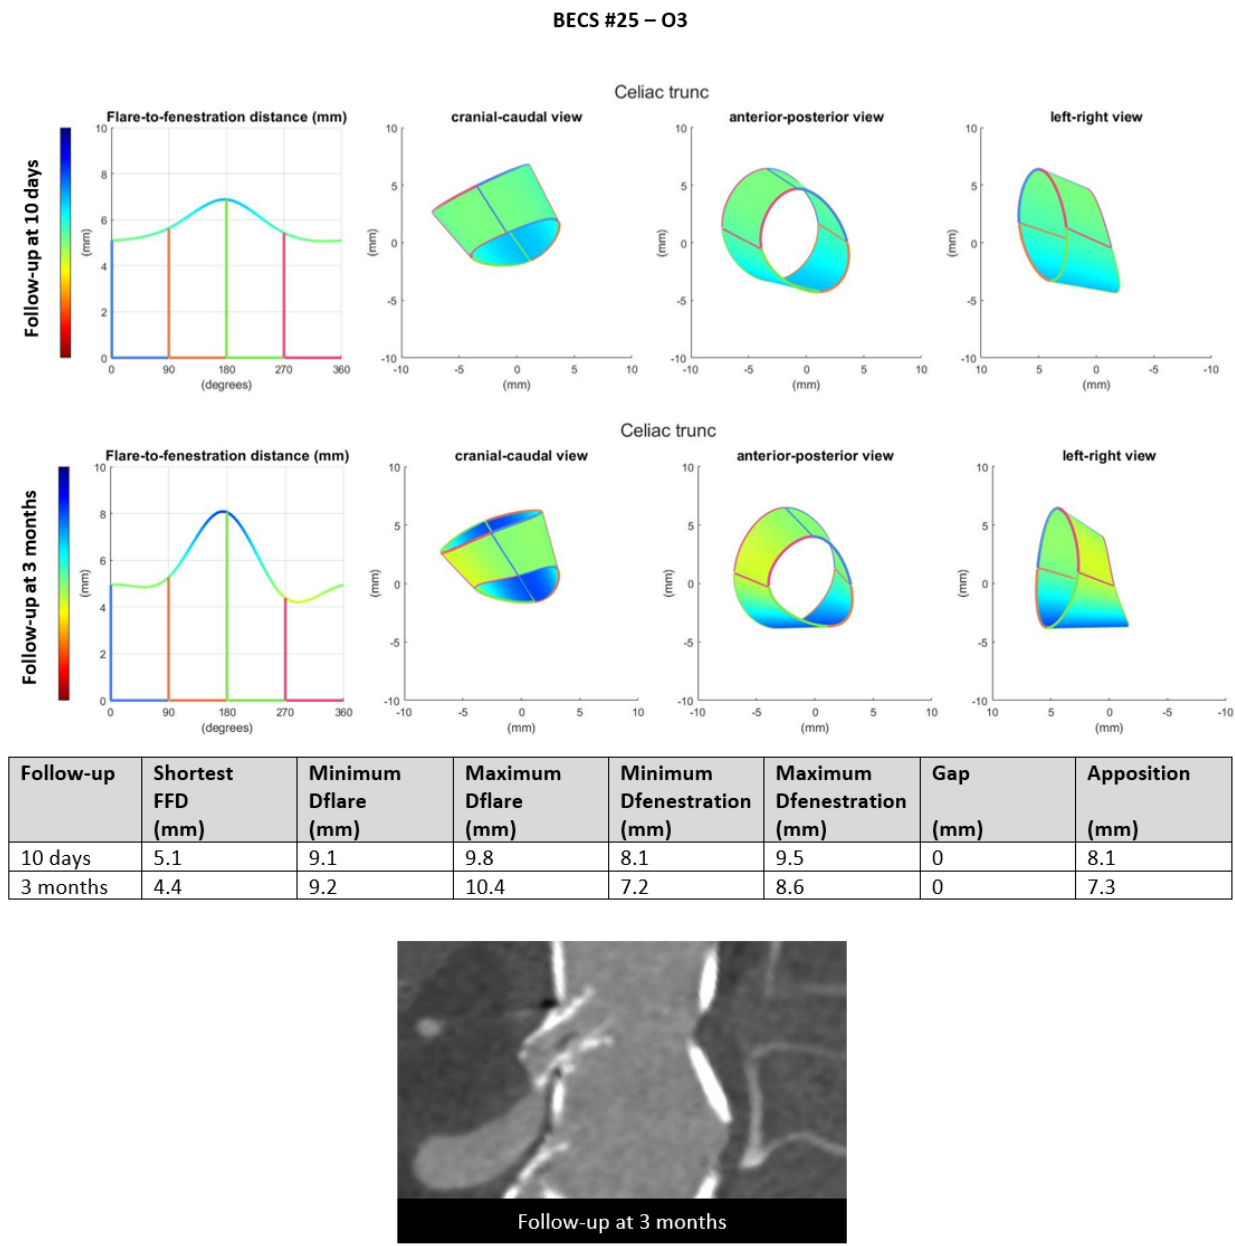
Figure 9. BECS #25 is an example of O3, obstruction due to misalignment or constriction of the distal end of the BECS with the target artery. At the top, geometric analysis of the 10 ‐ days and 3 ‐ months post ‐ FEVAR CTA scans showed a good flare without major geometrical changes. At the bottom, the snake view of the 3 ‐ month post ‐ FEVAR CTA scan showed 80% stenosis distal to the BECS due to median arcuate ligament compression.